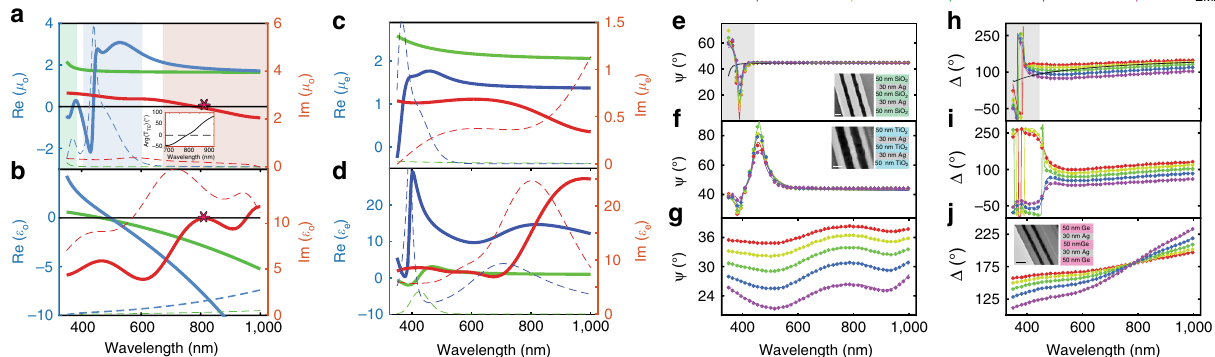
Fig. 3 Experimental veri fi cation of non-unity magnetic permeability in dielectric/metal metamaterials. Experimentally determined a μ o , b ϵ o , c μ e , d ϵ e for SiO 2 /Ag-green, TiO 2 /Ag-blue, Ge/Ag-red metamaterial. Shaded regions in a indicate the regime of magnetic resonances in μ o for the studied metamaterials. Solid lines represent real parts while dashed lines represent imaginary parts. Asterisks in a and b indicate the ϵ o and μ o near zero (EMNZ) wavelength for the Ge/Ag metamaterial. The EMNZ condition is con fi rmed by a vanishing phase of the transmission coef fi cient at the EMNZ wavelength, shown in the inset of a . e – g and h – j show the agreement between raw experimental data, Ψ and Δ respectively (which are the conventional ellipsometric angles), and the ellipsometric fi tting, for the SiO 2 /Ag metamaterial in e and h , for the TiO 2 /Ag metamaterial in f , i , and for the Ge/Ag metamaterial in g , j . Shaded regions in e , h emphasize the disagreement between experimental data and the effective medium approximation (EMA). Insets in e , f , j show TEM images of the fabricated samples. The scale bar is 50 nm for e , f and 100 nm for